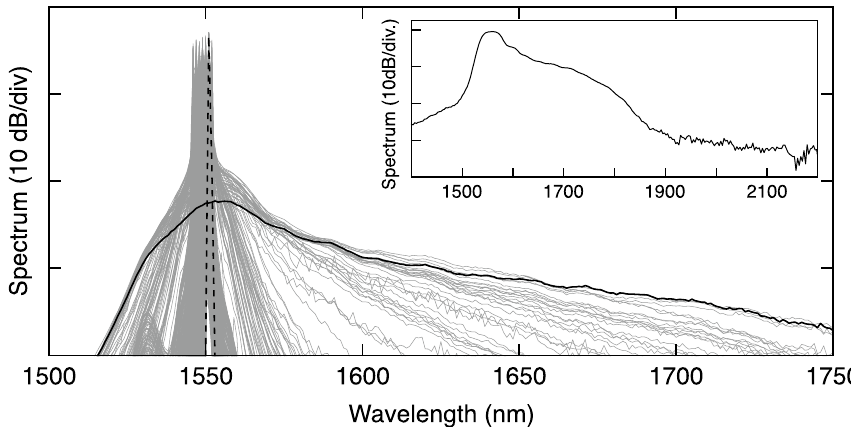
Figure 3. 2000 spectra measured with the Anritsu OSA, selected randomly from the full scan (gray curves). Specific examples of a narrowband spectrum (dashed black line) and a broadband spectrum (solid black line) are also shown. The inset plots a broadband spectrum measured using the NIRQuest spectrometer to show spectral extension above 1750 nm.